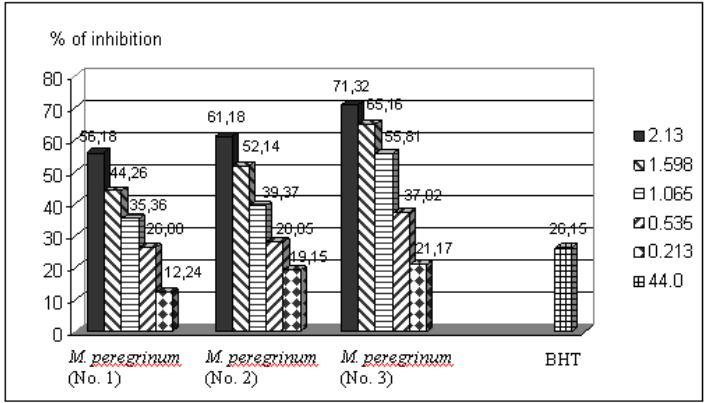
Figure 2. Inhibition of LP in Fe 2+ /ascorbate system of induction by essential oils of M. peregrinum from three different locations, and BHT (as a positive control). The essential oils and BHT were diluted in n -hexane (the solvent expressed no antioxidant activity) in the XOD